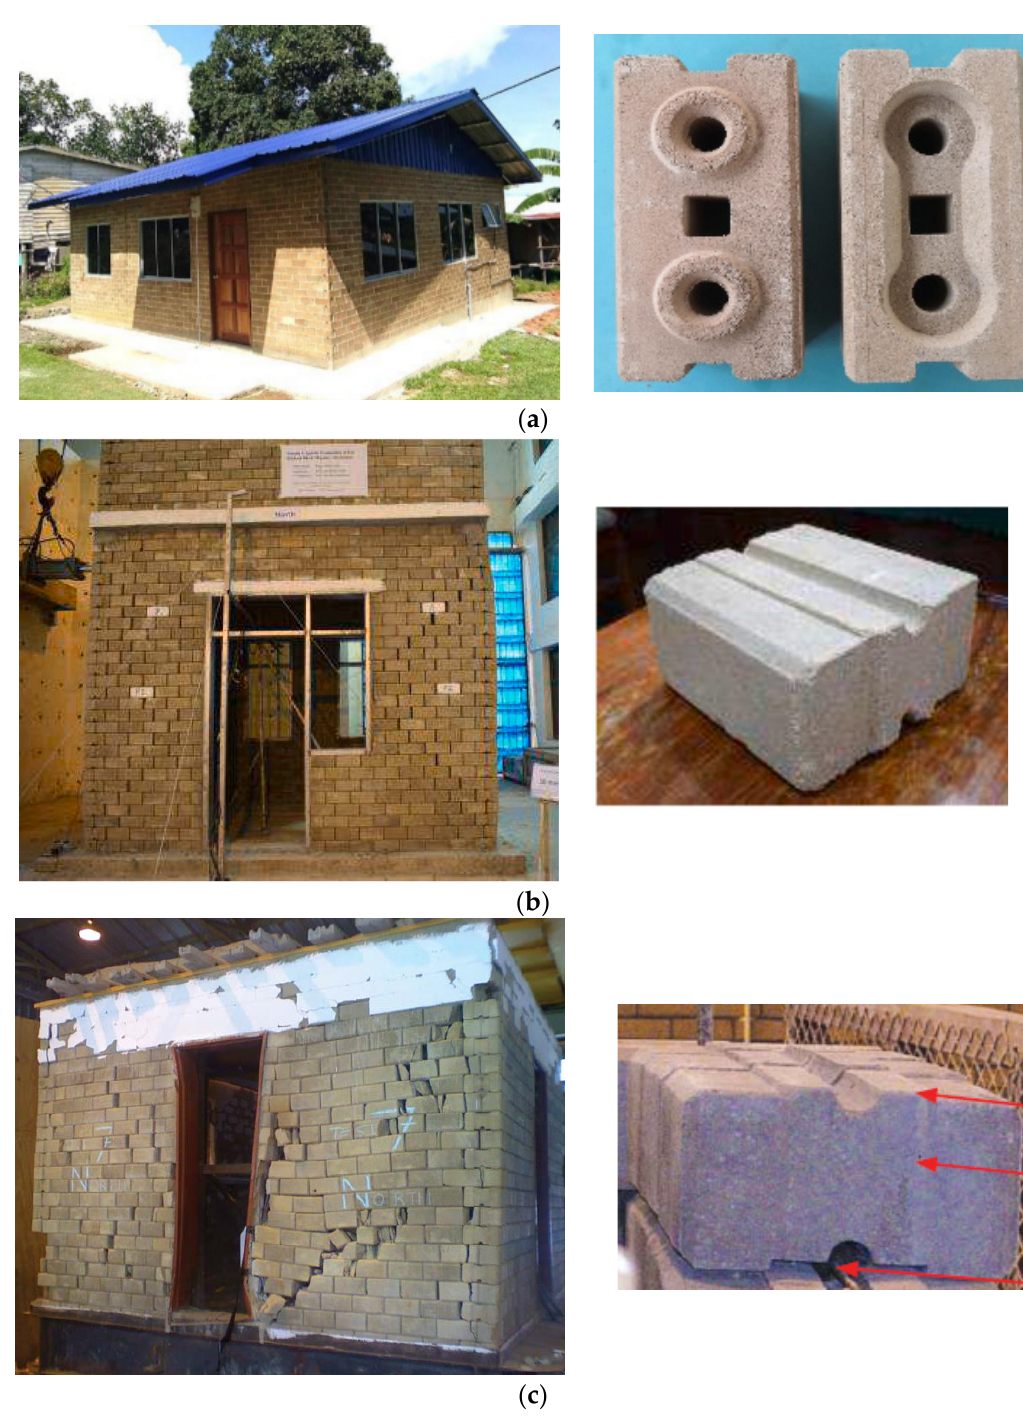
Figure 1. Interlocking structures reported by researchers: ( a ) Asman et al., [31], ( b ) Gul et al., [32] and ( c ) Elvin and Uzeogbo